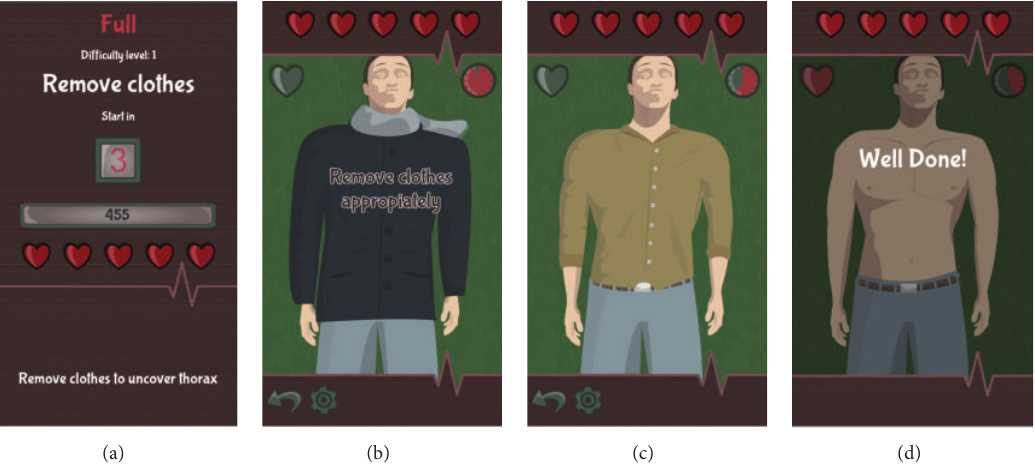
Figure 9: Game screens corresponding to the Remove Clothes mini game. (a) Init screen with game instructions. (b) Main scene with the victim wearing all the clothes. (c) After removing the scarf and the jacket. (d) Victim with the uncovered thorax.